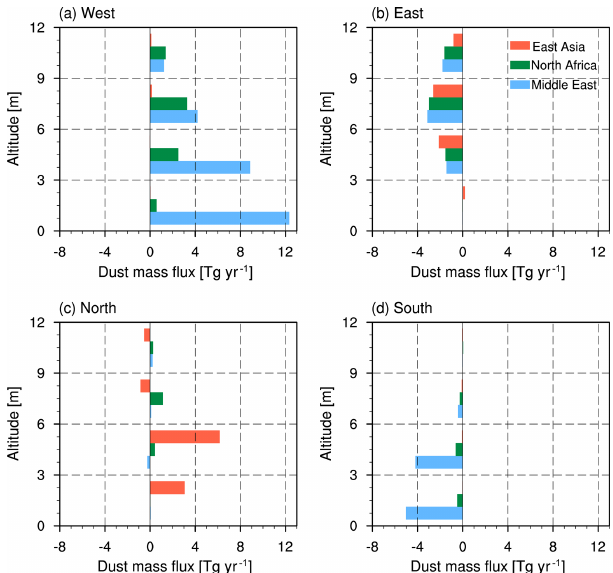
Figure 8. Model-based estimation of annual dust mass flux (in ter- agrams per year) at the (a) west, (b) east, (c) north, and (d) south sides of the Tibetan Plateau. The latitude ranges from 27 to 38 ◦ N, and the longitude ranges from 75 to 104 ◦ E. The west and east mass flux carried into the TP are based on the zonal wind, and the south and north mass flux are based on the meridional wind. Also, the values are positive for dust carried in and negative for dust flowing out.